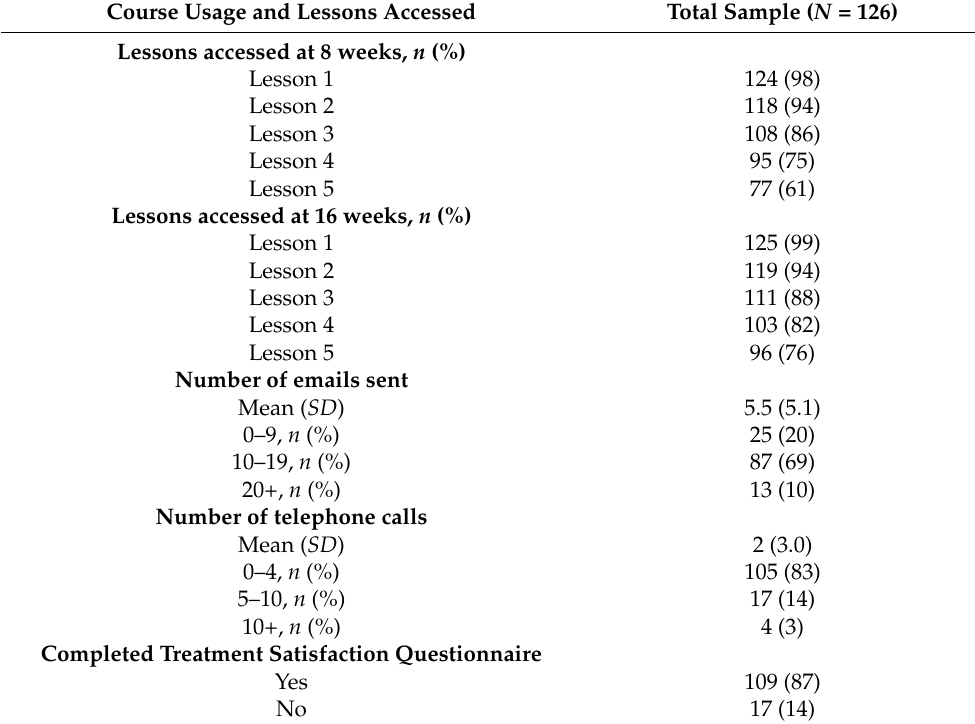
Table 2. Client course usage and lesson completion